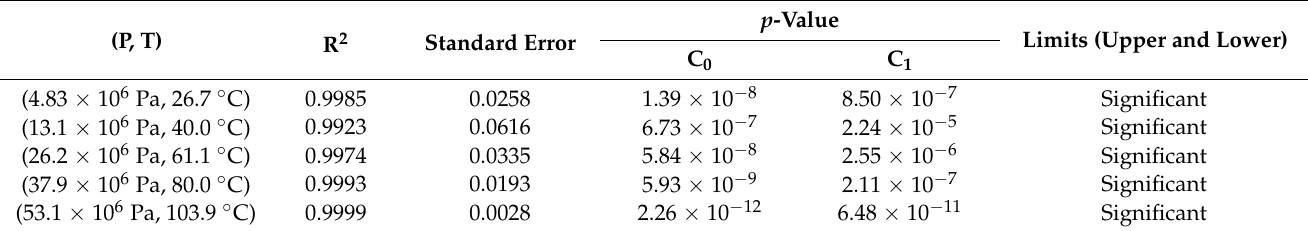
Table 7. Statistical analyses of the viscosity curves for the EDF fluid at HPHT conditions. (P,